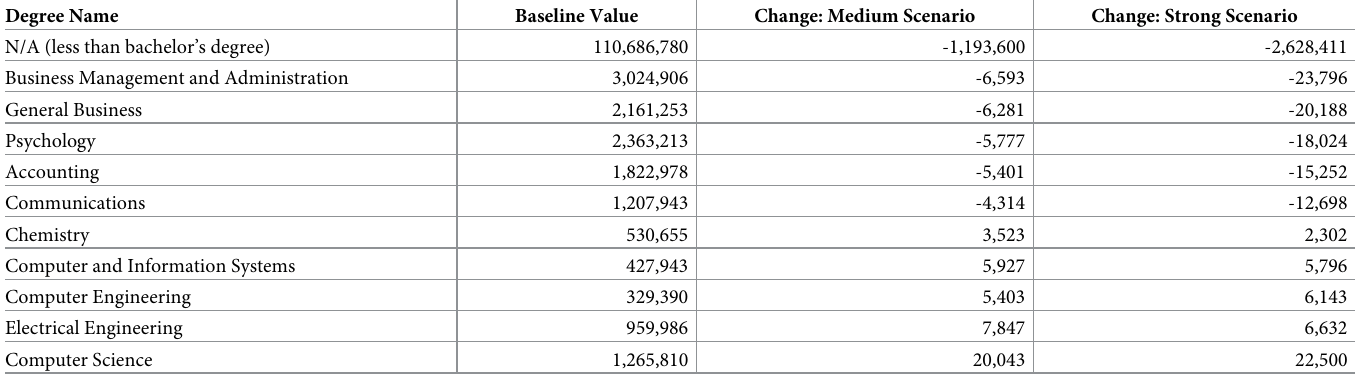
Table 4. Projected changes in total workers by degree.